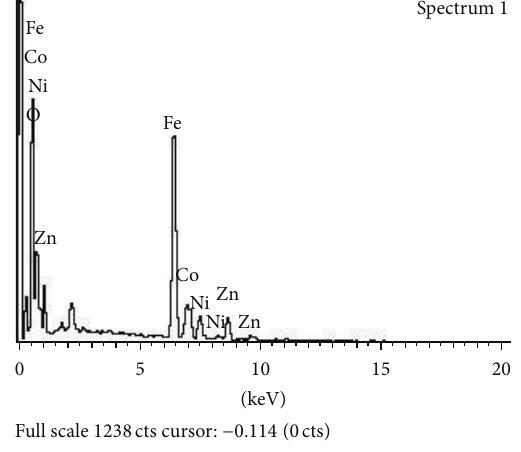
coercivity of the samples measured at room temperature are found to decrease with the increase in zinc